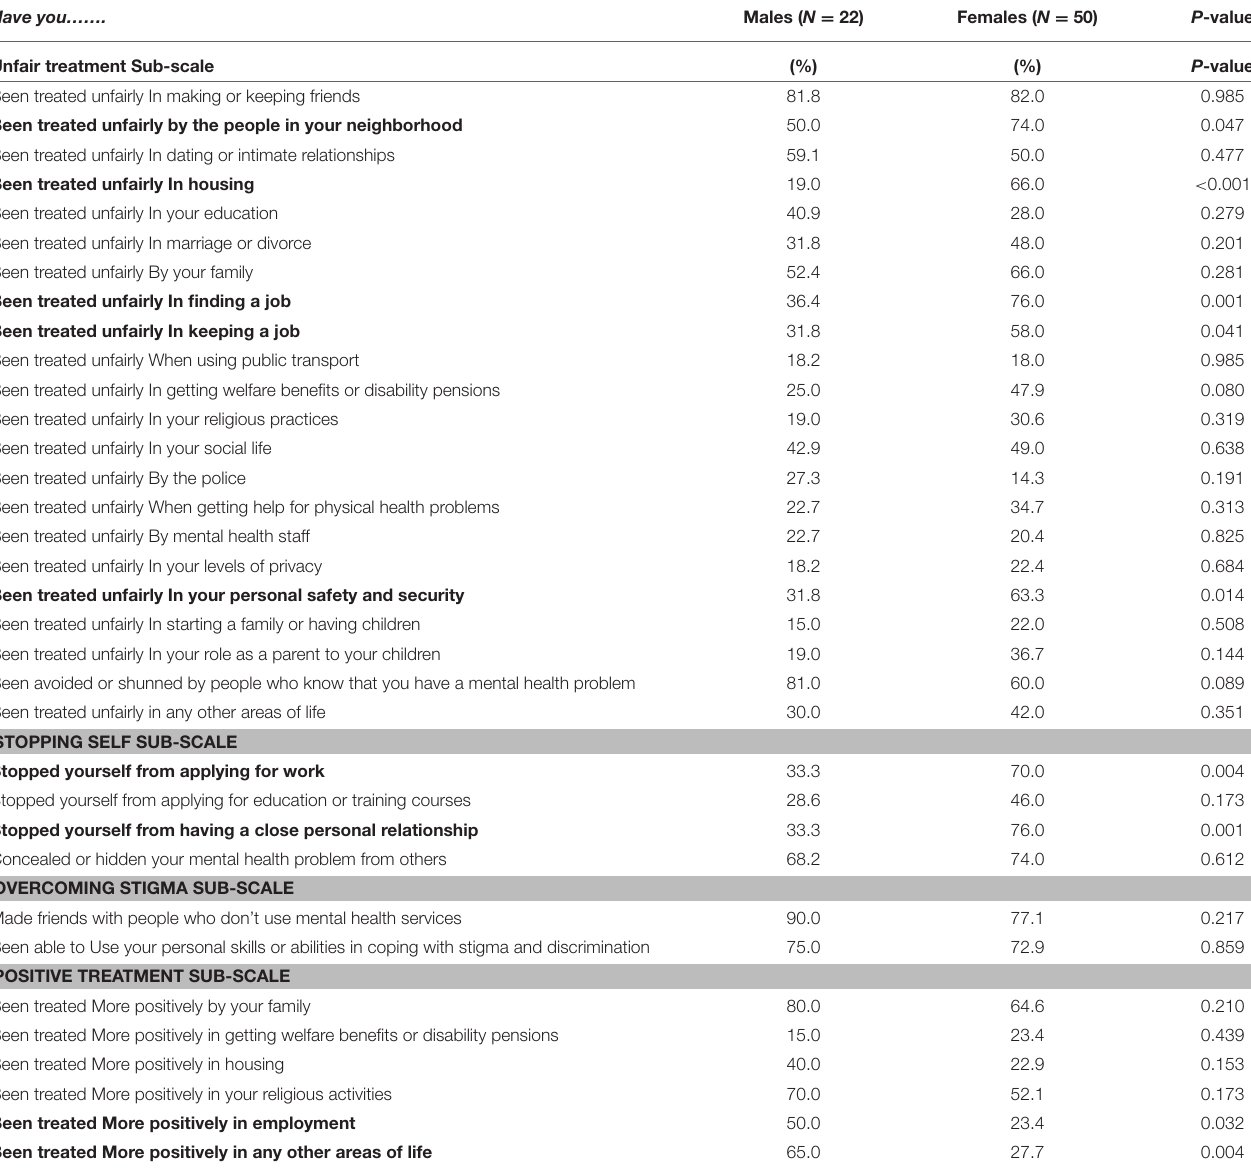
TABLE 3 | Proportion of agree responses for DISC items by gender. Have